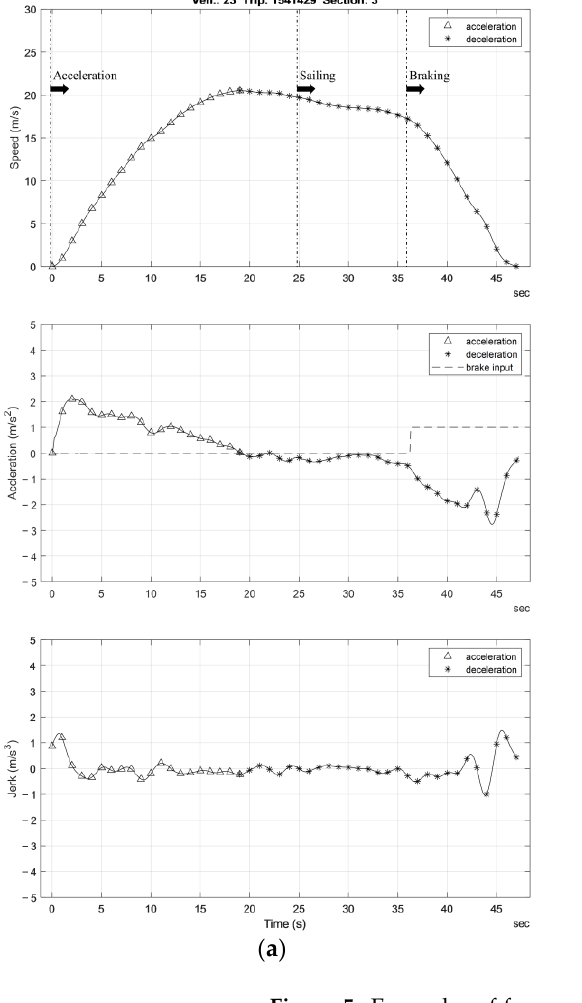
Figure 5. Examples of free acceleration/deceleration driving cases: ( a ) case of SPMD driver #23; ( b ) case of SPMD driver #57. Table 3. Summary of two drivers’